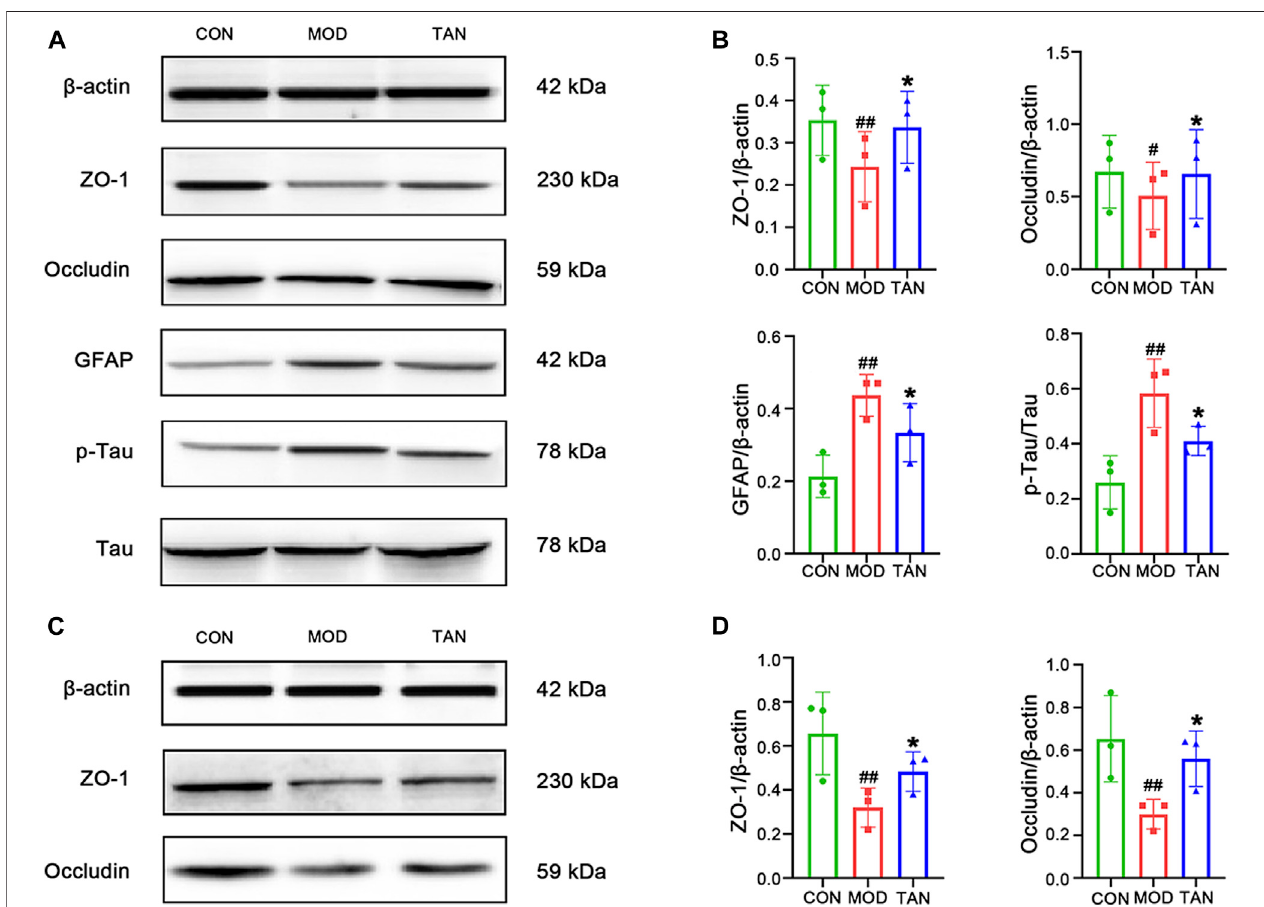
FIGURE 3 | TAN restored the neurological and colon tight-junction biomarkers. (A) Representative Western blot images and (B) their statistical analysis of protein expressions of ZO-1, occludin, GFAP, p-Tau/Tau in the hippocampus ( n = 3 independent experiments). # p < 0.05, ## p < 0.01 vs . CON group and * p < 0.05 vs . MOD groupbyone-wayANOVA. (C) .RepresentativeWesternblotimagesfromthethreeindividualexperimentsand (D) theirstatisticalanalysisofproteinexpressionsofZO-1 andoccludinincolontissues( n ≥ 3). # p < 0.05vs . CONgroupand* p < 0.05vs . MODgroupbyone-wayANOVA.TAN,tanshinoneIIA;CON,control;MOD,model; ANOVA, analysis of